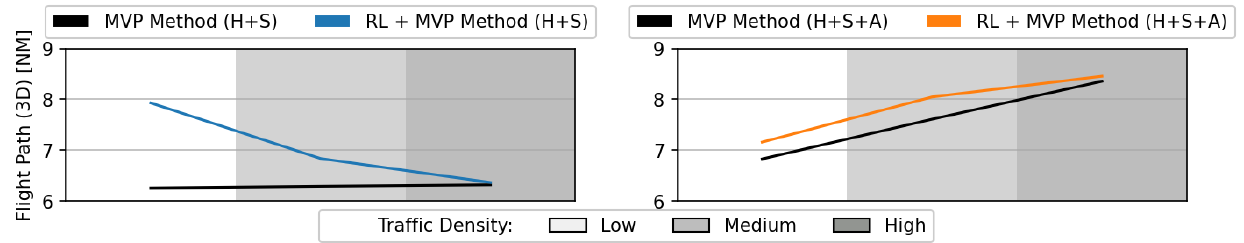
Figure 18. Three-dimensional flight path during testing of the RL